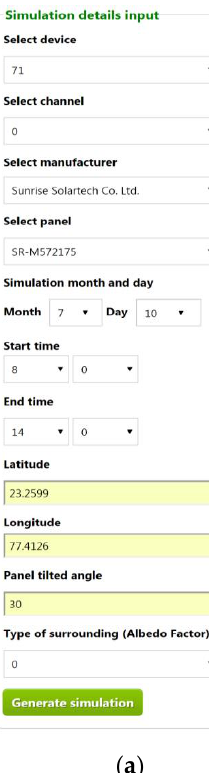
Figure 11b. The day selected (10 July 2015) and time (9:00 A.M.) give the operating data I MPP = 1.754 A and V MPP = 32.4 V at insolation 352 W/m 2 and temperature 26.05 °C , and the simulation ( I-V and P-V characteristic) obtained from the emulator is shown in Figure 12.